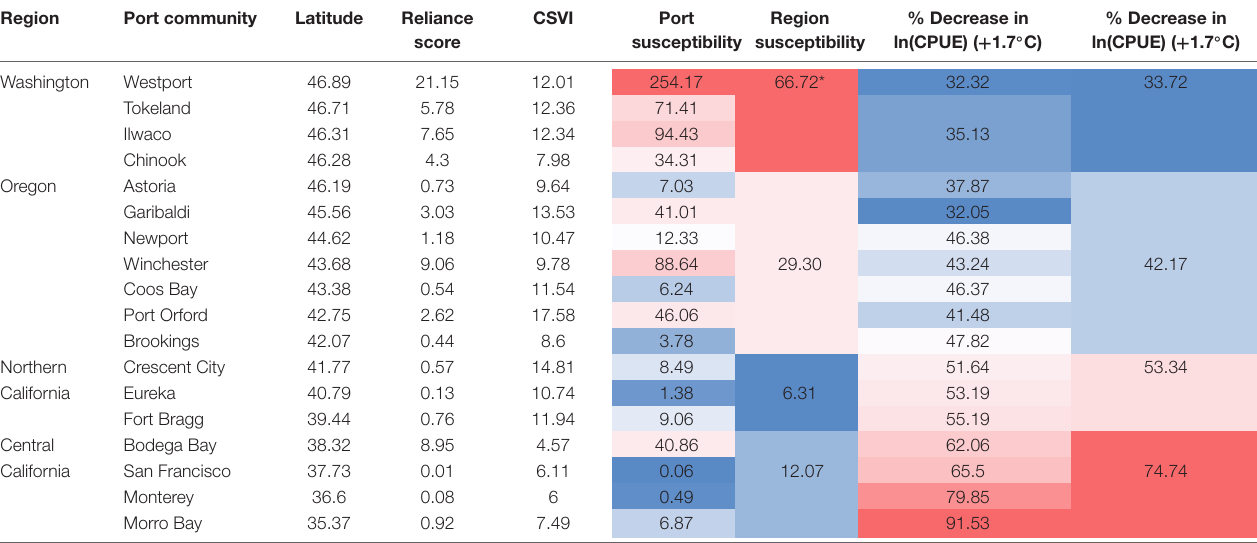
TABLE 4 | Reliance index, community social vulnerability index (CSVI), susceptibility score, and predicted percent decrease in ln(CPUE) by port and by region (NOAA, 2017; Varney, 2018). Region Port